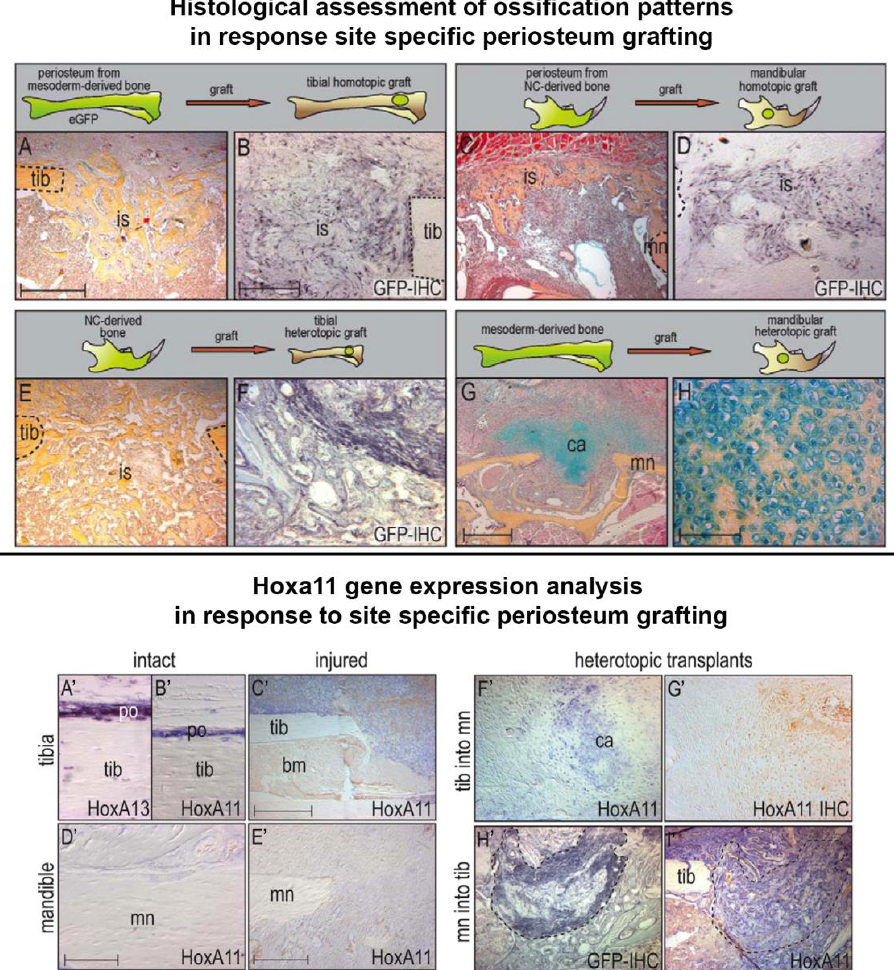
Figure 5. The capacity of bone derived mesenchymal cells to participate in bone restoration is dependent on both the donor and recipient site. Top panel: Robust tibia bone repair, whereby pentachrome staining indicates intramembranous ossification ( A ), is facilitated directly by the homographic translation, survival and differentiation of GFP-positive tibial periosteum at the site of injury ( B , GFP immunohistochemistry). A similar response is documented in mandibular sites ( C ) transplanted with GFP-positive mandibular periosteum ( D ). Although intramembranous bone is